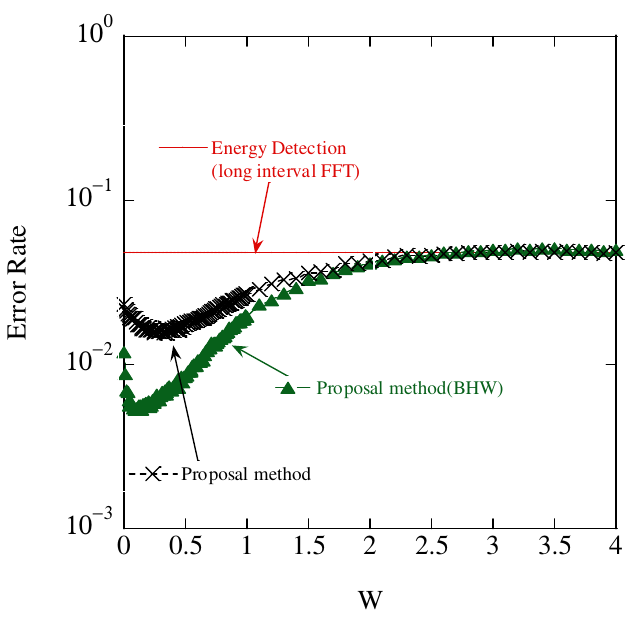
Figure 13. Aggregate accuracy